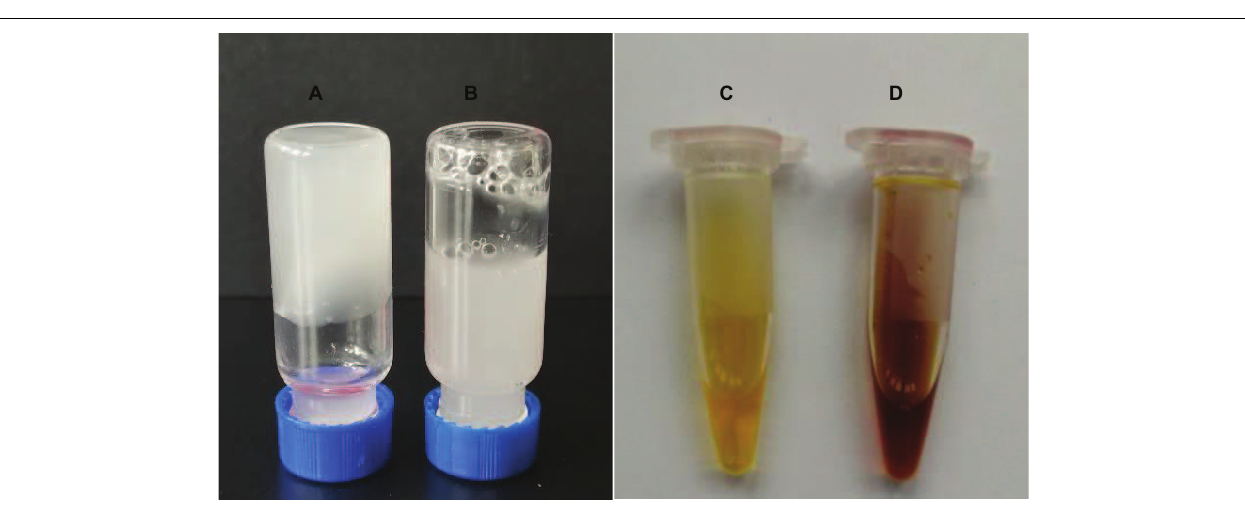
Frontiers in Microbiology |